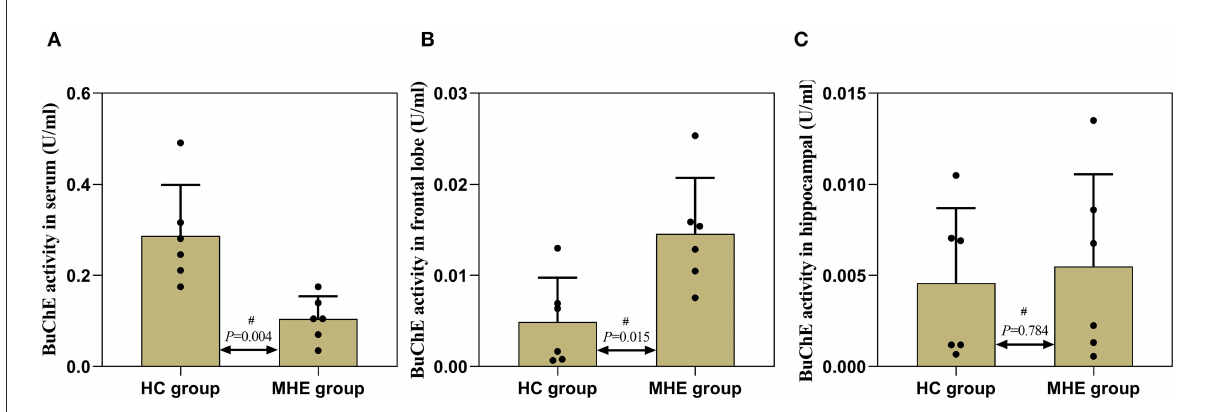
FIGURE6 BuChE activity in the peripheral and central of MHE and control rats. (A) BuChE activity in serum; (B) BuChE activity in frontal lobe tissue; (C) BuChE activity in hippocampal tissue; # Mann–Whitney U